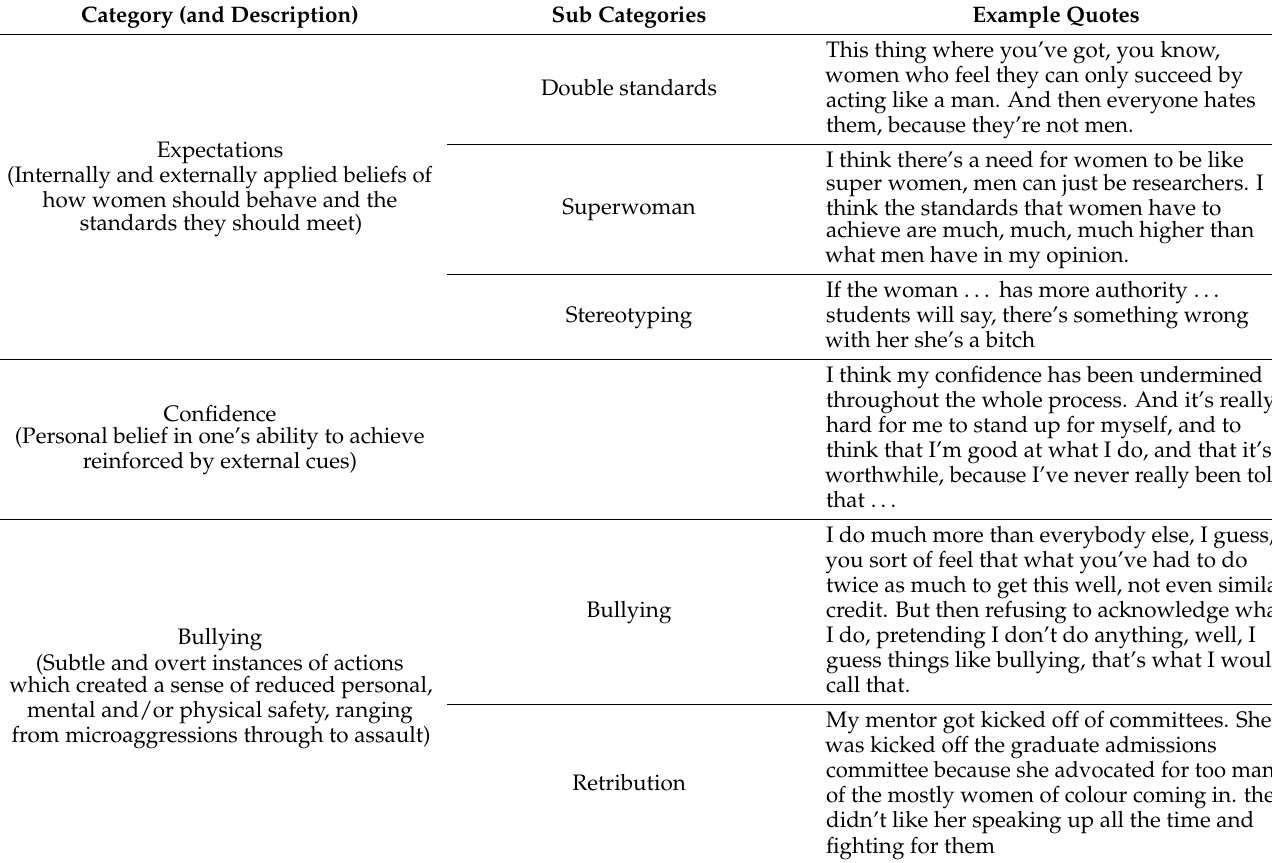
Table 1. Code categories identified from focus group transcripts with exemplars of quotes used in the qualitative analysis. Category (and